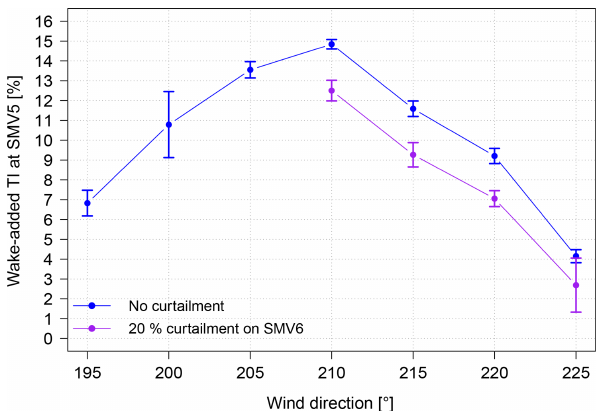
Figure 10. Variation of wake-added TI as a function of wind direc- tion, in normal operation and during SMV6 curtailment. Error bars indicate the 68% normalized confidence